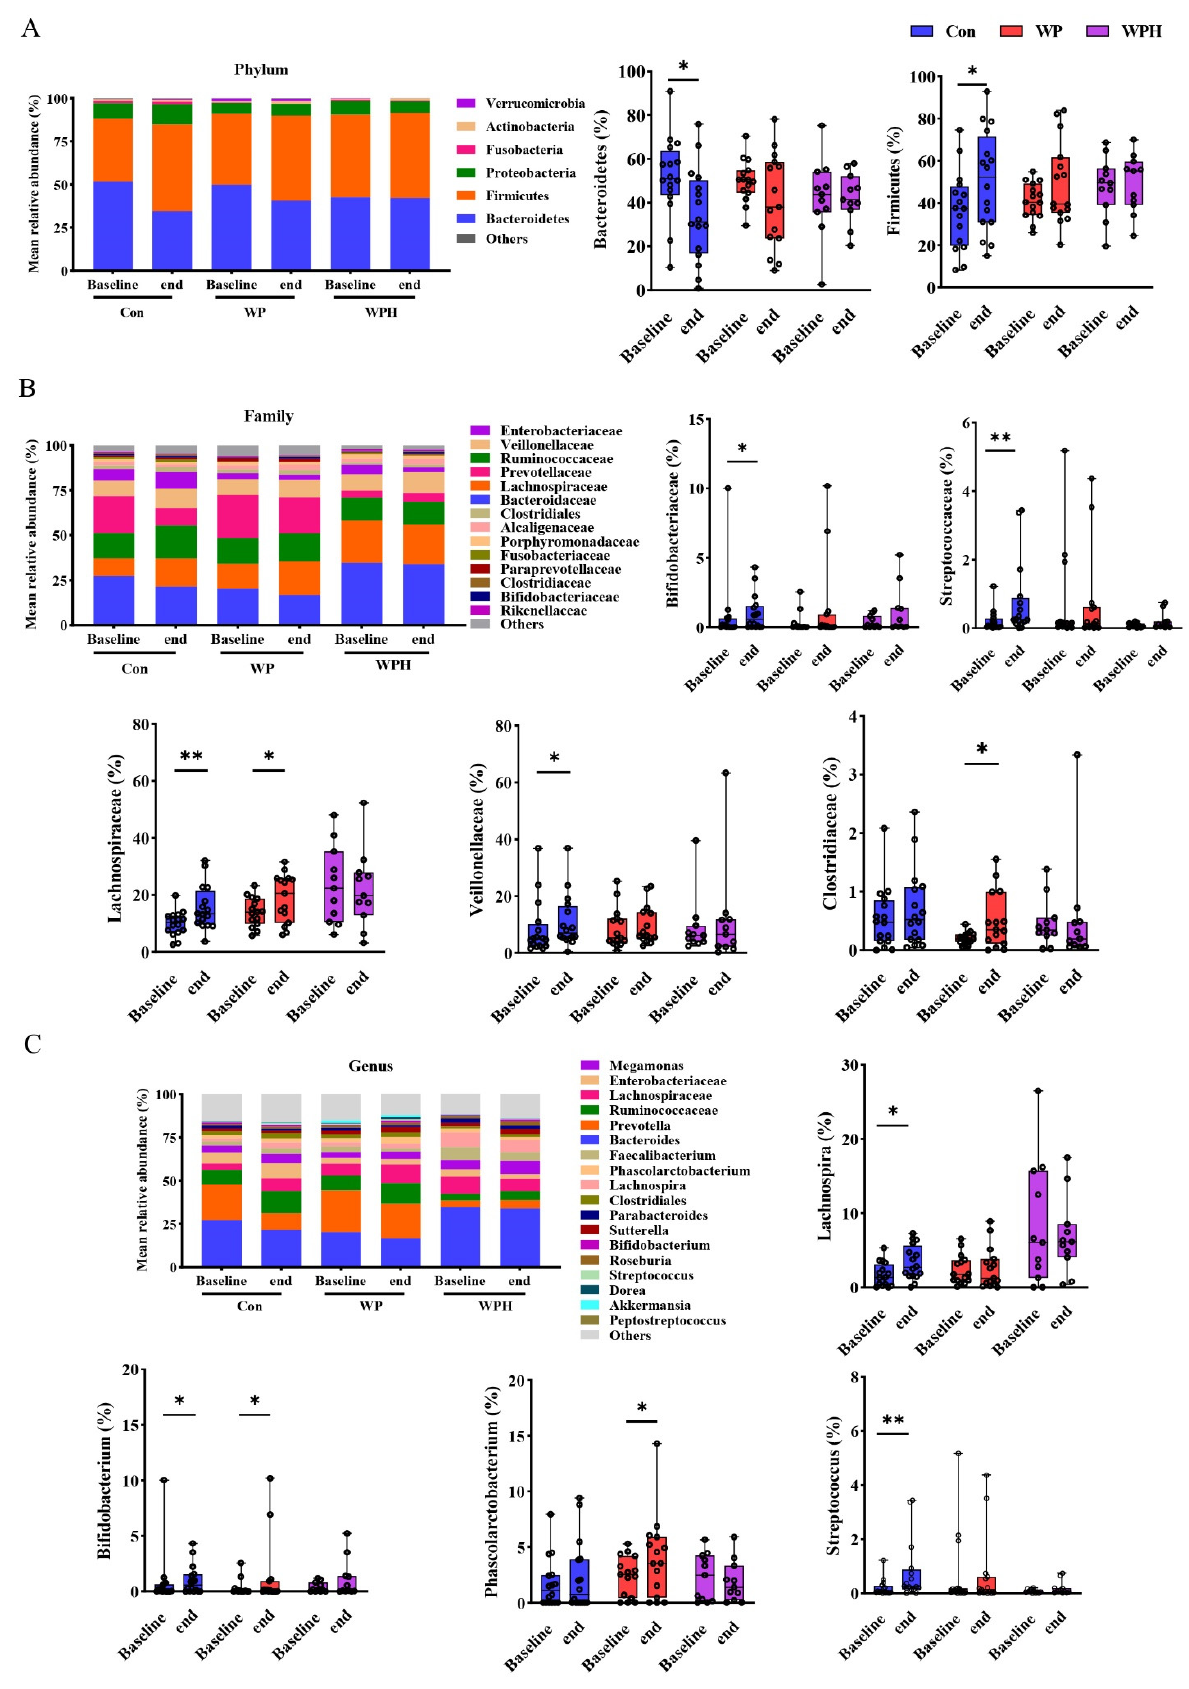
Figure 4. Changes in overall gut microbiota at three levels after intervention in each group, at the phylum ( A ), family ( B ), and genus ( C ) levels. * p < 0.05, ** p <